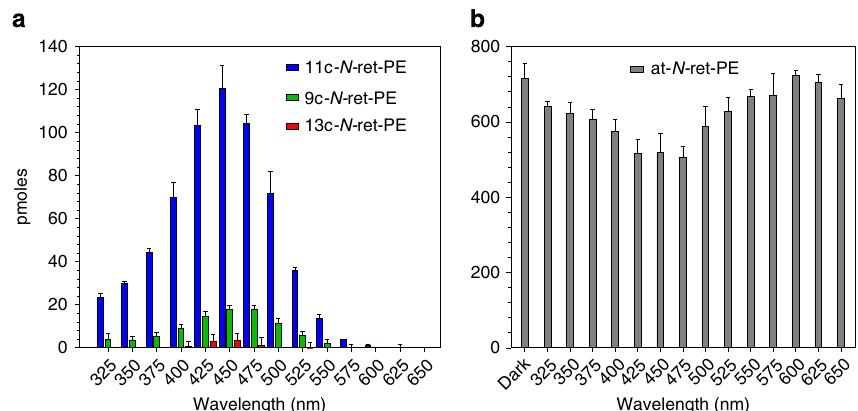
Fig. 1 Action spectrum for photoisomerization of protonated at- N- ret-PE. Protonated at- N- ret-PE in acidi fi ed methanol was incubated in the dark or under monochromatic light of the indicated wavelengths and the same photon fl ux. a Molar composition of 11c-, 9c- and 13c- N- ret-PE isomers following the incubation in light. The dark background level of each isomer was subtracted. Note the 37-fold higher level of 11c- versus 13c- N- ret-PE in the 450-nm samples. b Molar amounts of at- N- ret-PE remaining after incubation in the dark or in light of the indicated wavelengths. Data are plotted as mean ±